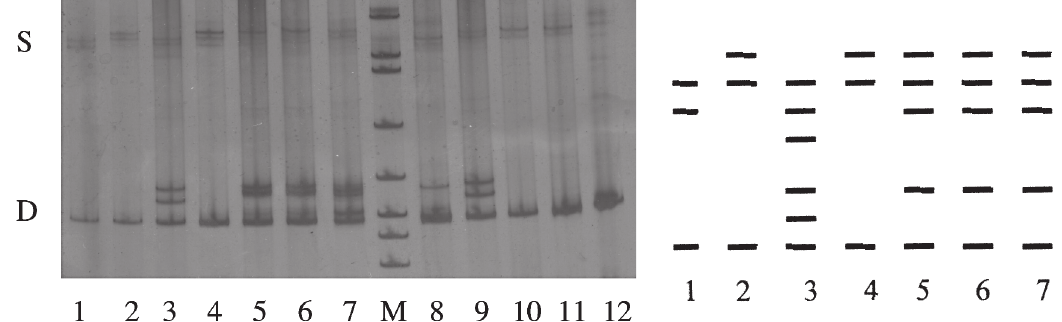
3. – SSCP analyses of Ag6 DNA sequence. S: single-stranded DNA, D: double-stranded DNA, M: pGEM DNA marker, (Promega), lanes 1 and 8: homozygotes a1a1, lanes 2, 4, 10, 11: homozygotes a3a3, lanes 3 and 9: heterozygotes a1a2, lanes 5, 6, 7: heterozygote a1a3, lane 12